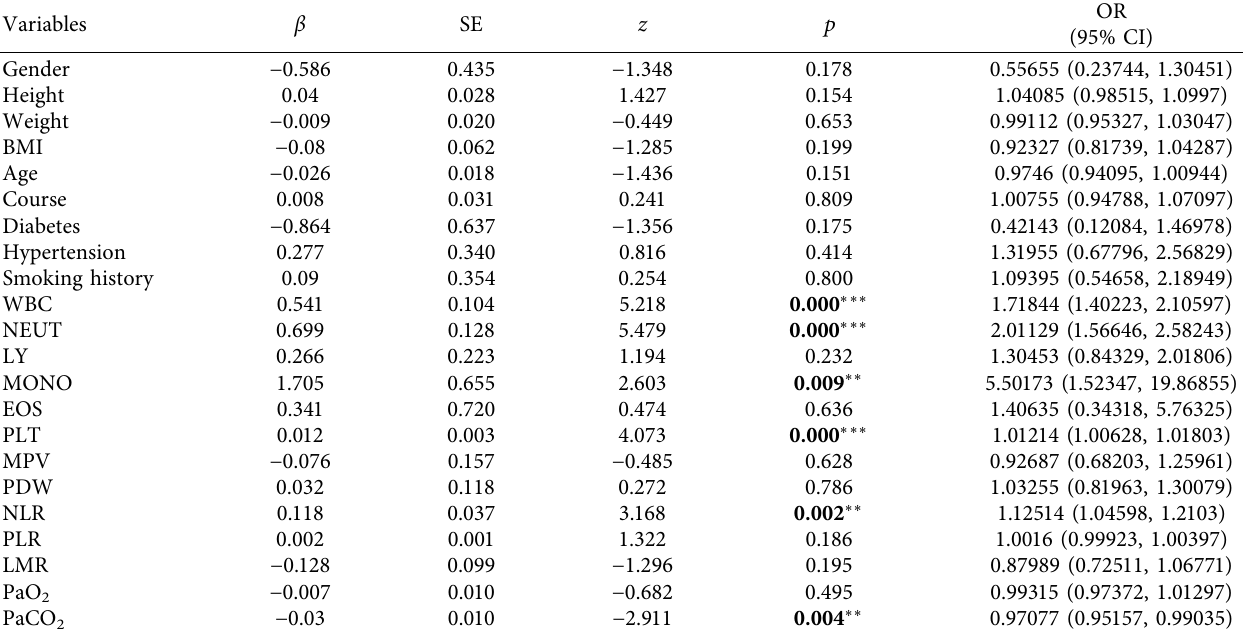
Figure 1: Te diference in clinical characteristics, including WBC (a), NEUT (b), MONO (c), PLT (d), NLR (e), and PaCO mild-to-moderate and severe COPD groups. Table 2: Results of univariate logistic regression analysis on infuencing factors of severity in COPD